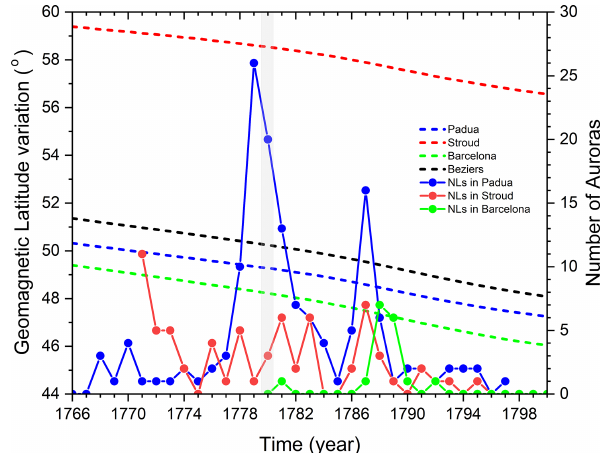
Figure 2. Geomagnetic latitude variations for Padua, Barcelona, Stroud and Béziers and yearly total auroras recorded in these places by Toaldo, Salva and Hughes. The grey column indicates the year of Rozier’s auroral observation,